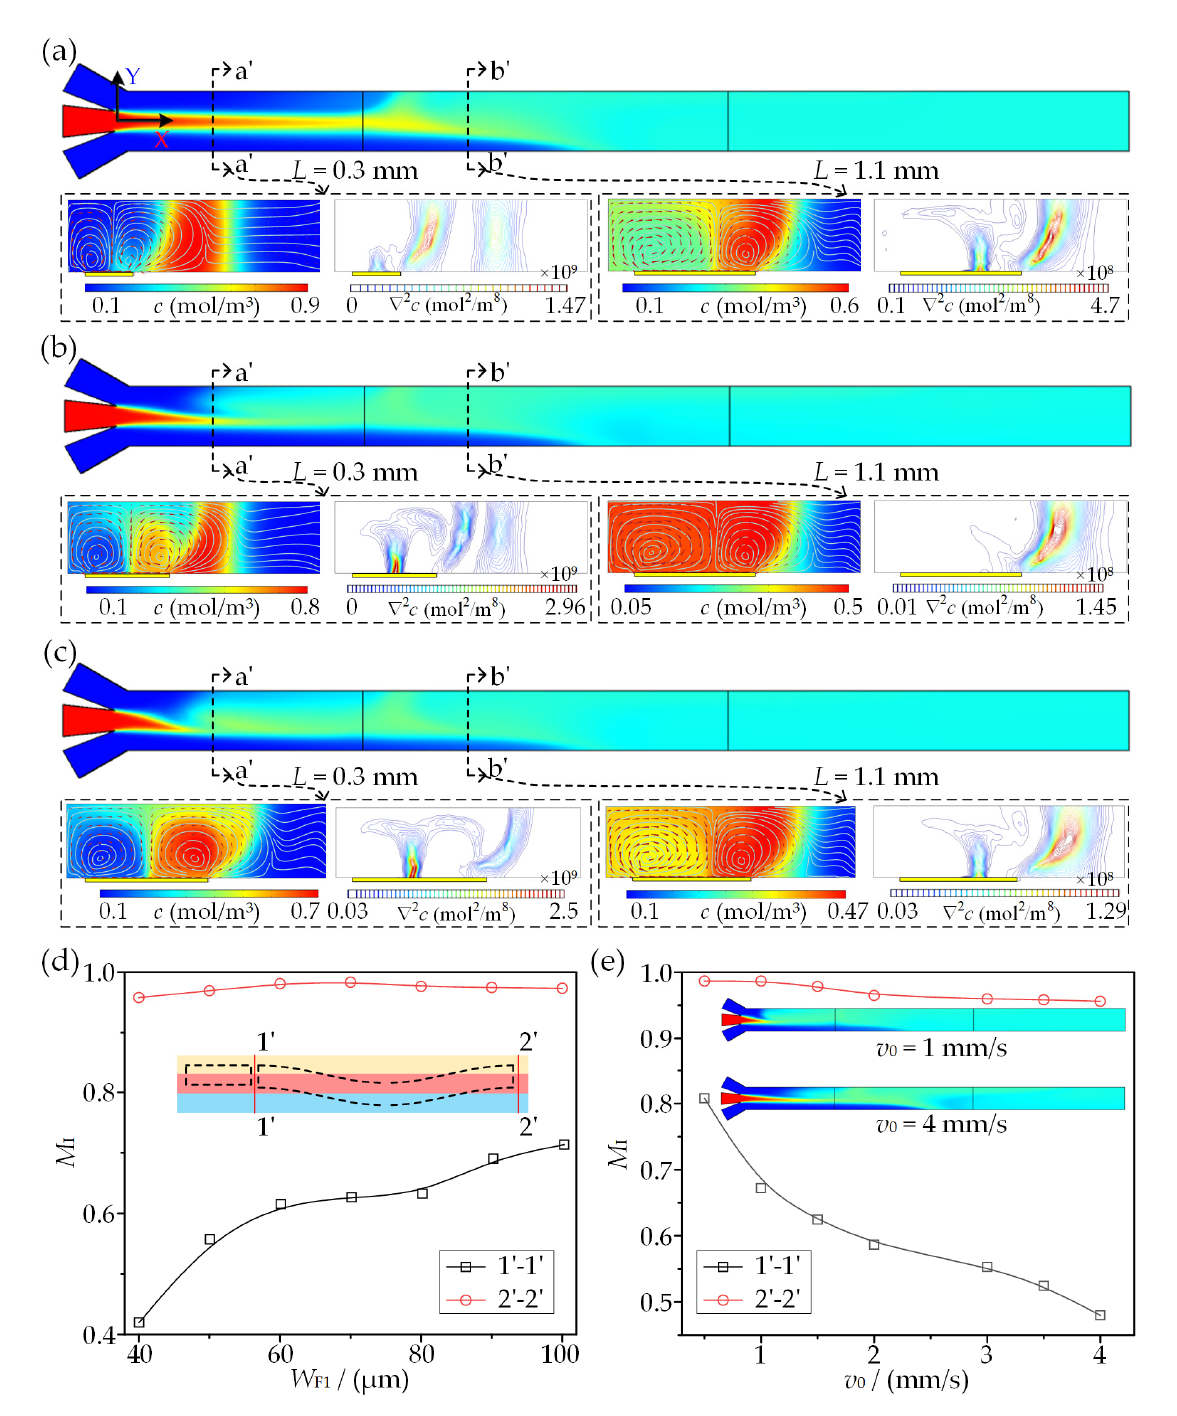
Figure 9. Analysis of mixing performance for three-fluid sequential micromixing at A = 10 V and f = 200 Hz. ( a – c ) Concentration distribution and the corresponding concentration gradient at W F1 = 40, 70, and 100 µm, respectively. ( d ) Mixing efficiency at cross sections after SFE and SSFE in terms of W F1 . ( e ) Influence of inlet flow velocity on mixing index.